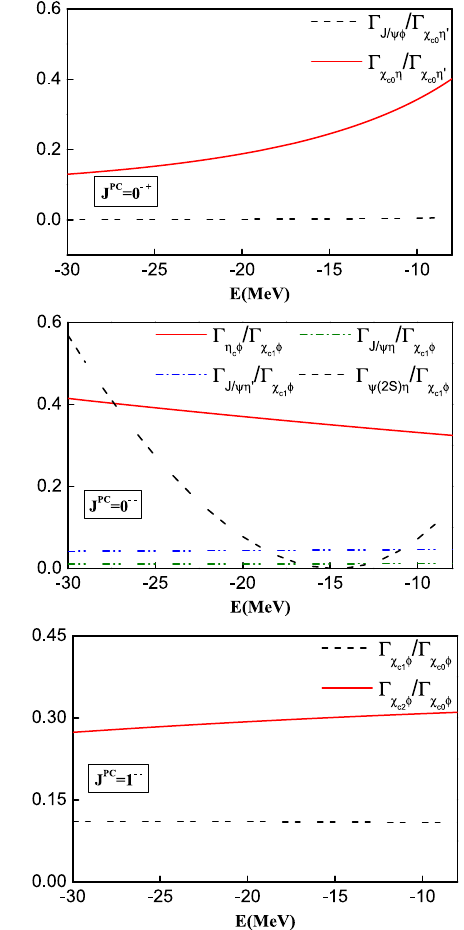
Fig. 5 Thebindingenergydependenceofthedecaywidthratiosforthe D ∗ s ¯ D s 1 molecularcandidateswith J PC = 0 −+ , 0 −− , 1 −−